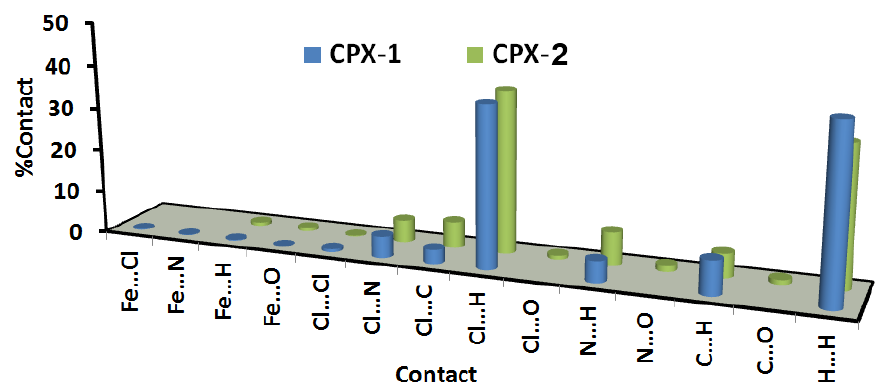
Figure 6. All intermolecular interactions in complexes (CPXs) 1 and 2 .